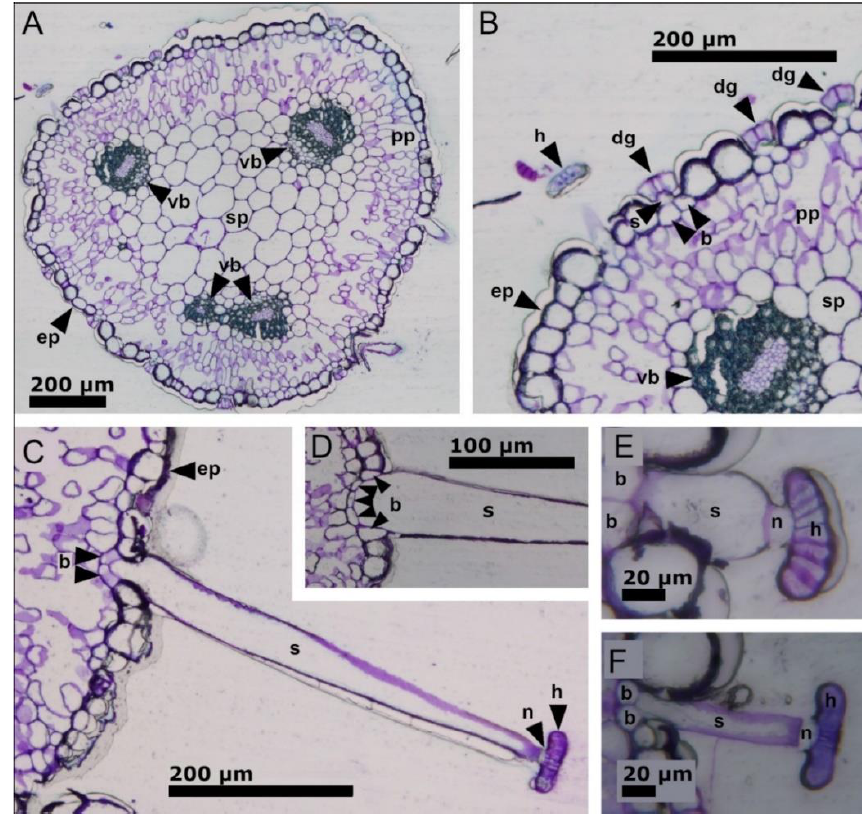
Figure 9. Light microscopy investigations of B. gigantea leaves and stalked glands. ( A ) Cross section of a leaf. The vascular bundles, epidermis, palisade parenchyma and spongy parenchyma are visible. ( B ) Detail from ( A ). The digestive glands with basal cells and short stalk cells and a single stalked gland with the head are visible. ( C – F ) Individual stalked glands with basal cells (two in C , E , F ; five in D ), long stalk cells, neck cells (which did not stain well with toluidine), and heads. Abbreviations: b = basal cell; dg = digestive gland; ep = epidermis; h = head; n = neck cell; pp = palisade parenchyma; s = stalk cell; sp = spongy parenchyma; and vb = vascular bundle.